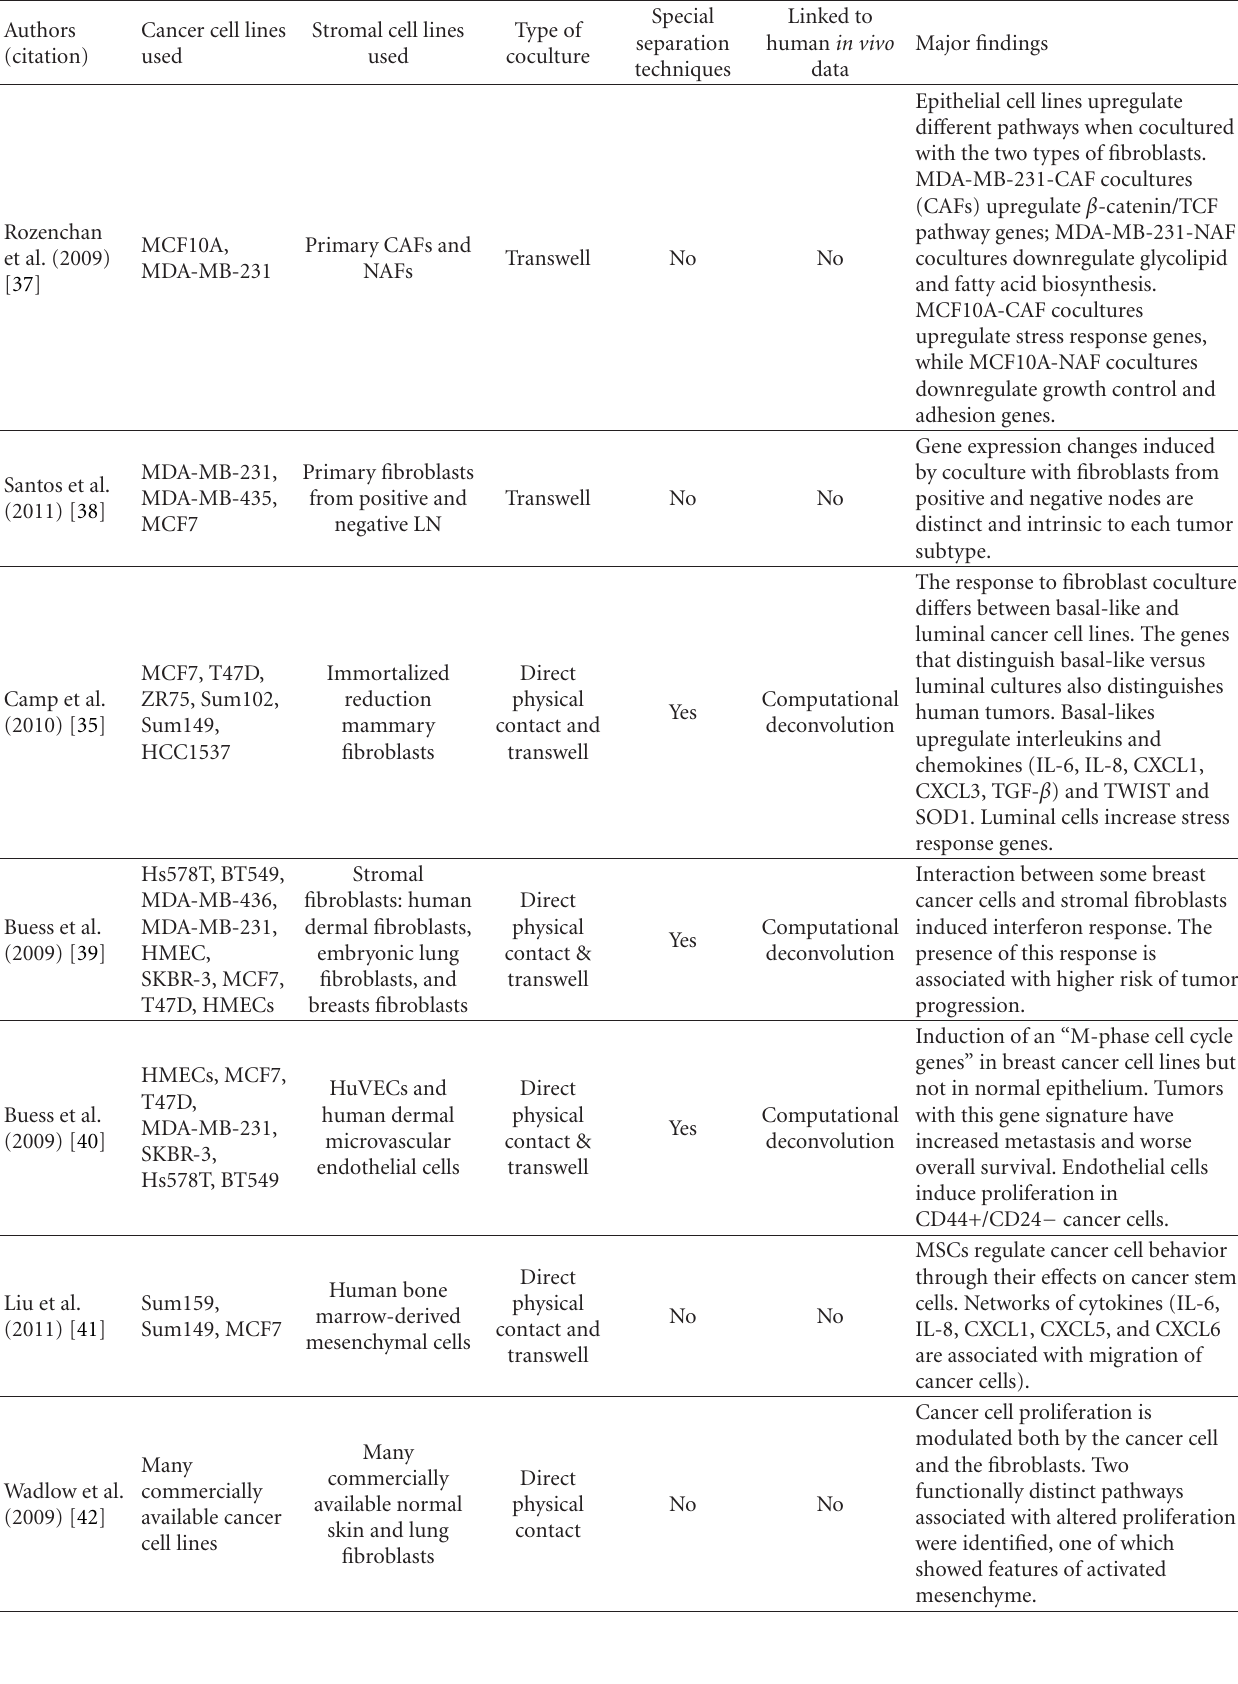
Table 2: Whole genome microarray studies to investigate breast cancer tumor microenvironment in vitro